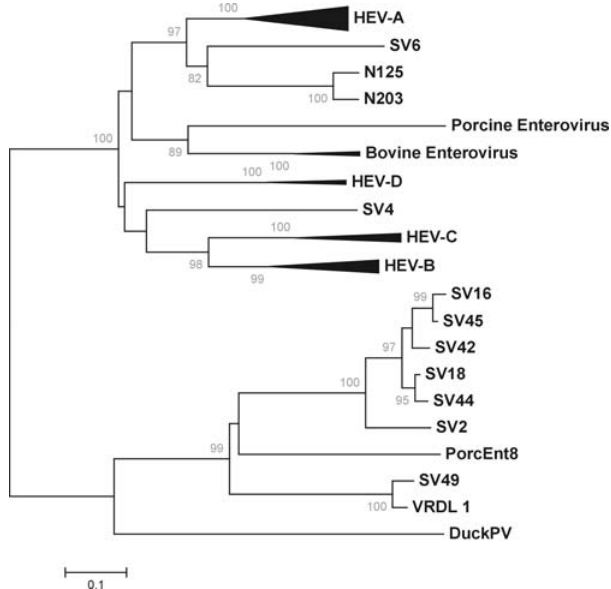
Figure 2. Phylogenetic analysis of likely simian Sapelovirus. Unrooted neighbor-joining phylogenetic relationships based on align- ment of VP1 amino acid sequences, including partial simian virus genomes. Bootstrap analysis with 1000 pseudo-replicates was utilized.